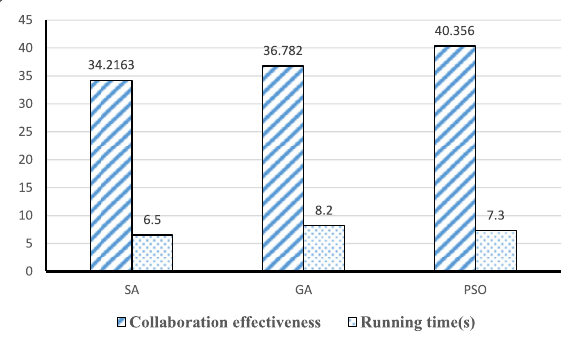
Figure 10 Comparison of algorithm